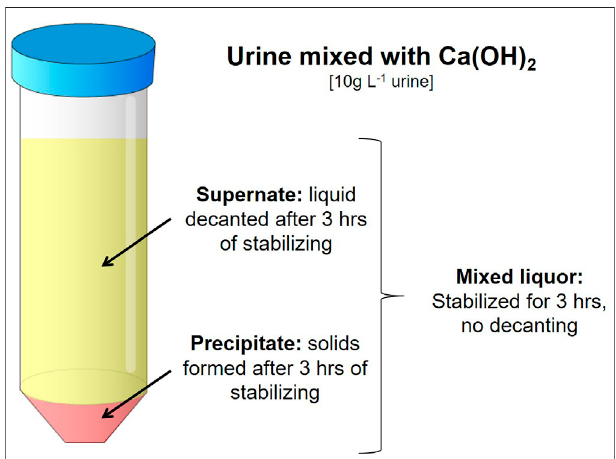
FIGURE 1 | The three fractions made from the stabilized urine/Ca(OH)2 solution. Mixed liquor being the whole agitated mixture. The Supernate and Precipitatefractionsweremadebydecantingthesolutionaftersettling for3 h.